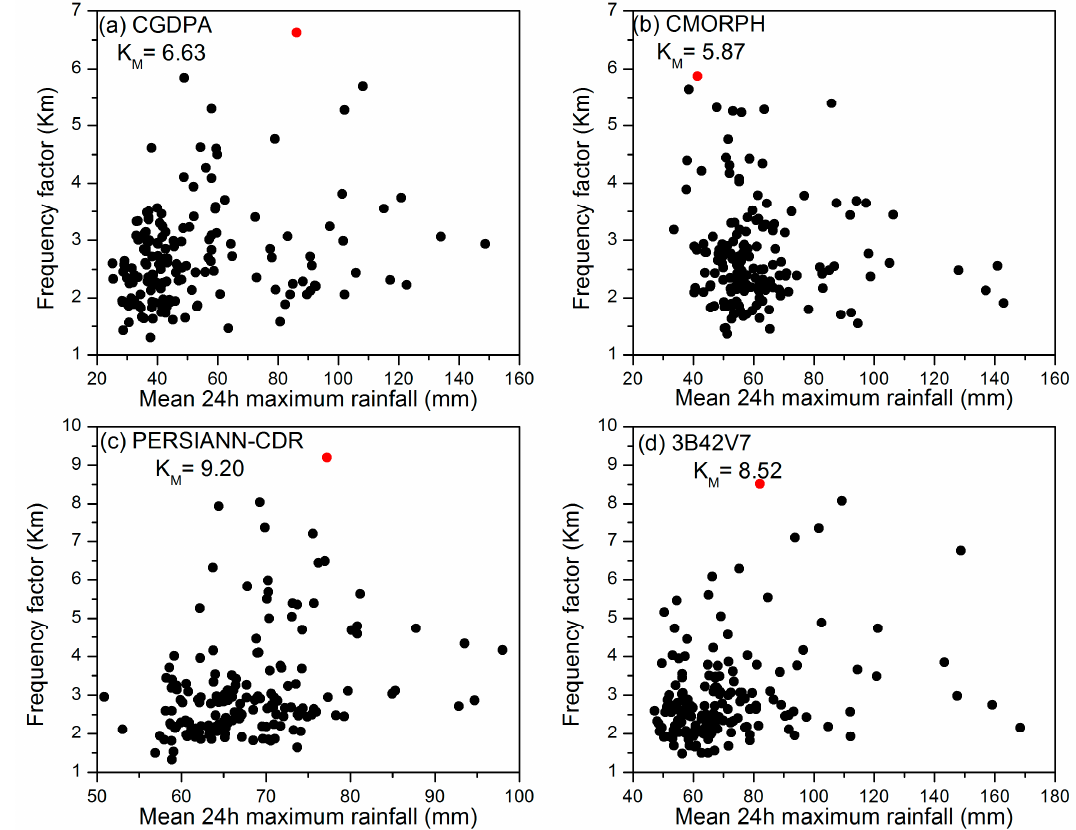
Figure 7. Plot of frequency factor against mean 24-h maximum rainfall (the red dots represent the largest values of K m for the whole basin).